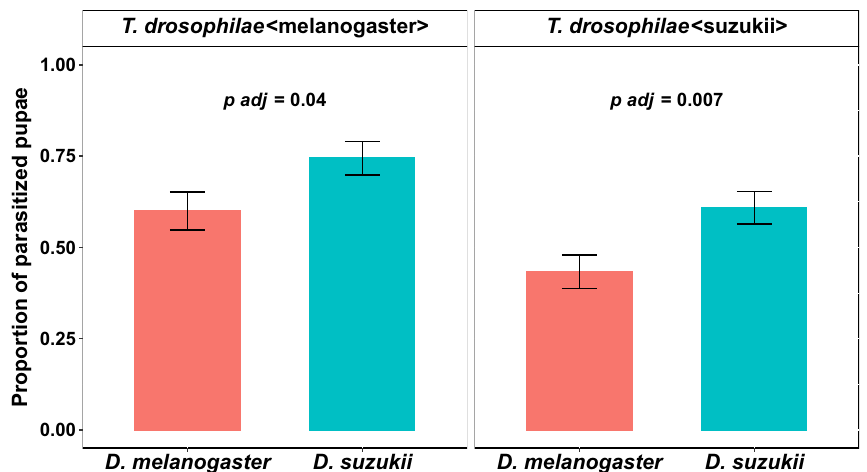
Figure 1. Proportion of parasitised pupae of D. suzukii (blue) and D. melanogaster (red) by the wasp T. drosophilae . The wasp was reared on either D. melanogaster pupae (left side) or D. suzukii pupae (right side) (Wilcoxon rank-sum